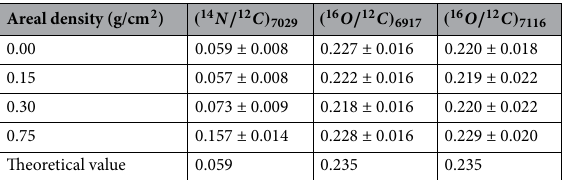
Table 1. The predicted element ratio for cocaine wrapped in caffeine with different areal densities.